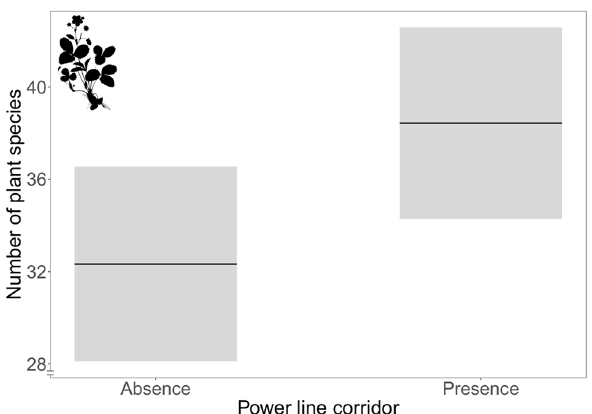
Figure 1. Species richness of plant species is in average ~ 6 species higher in landscapes with power line corridors than in landscapes without power line corridors. The grey bands represent the 95%